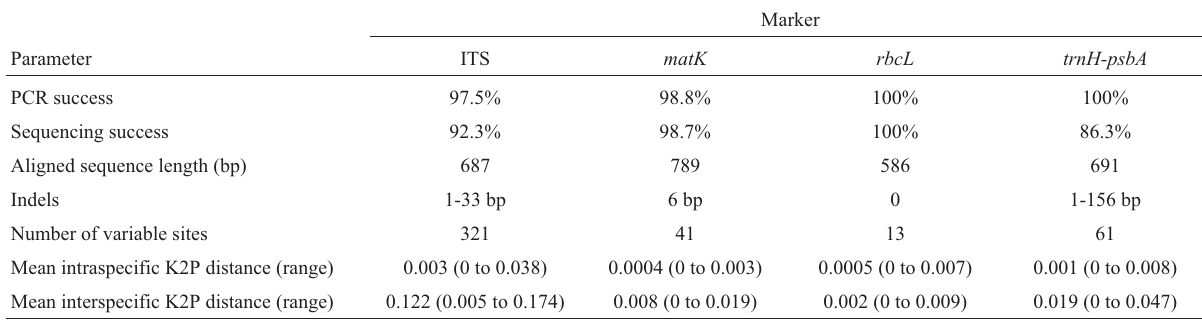
Table 2 - Evaluation of four genomic markers for the molecular identification of Sapotaceae species.